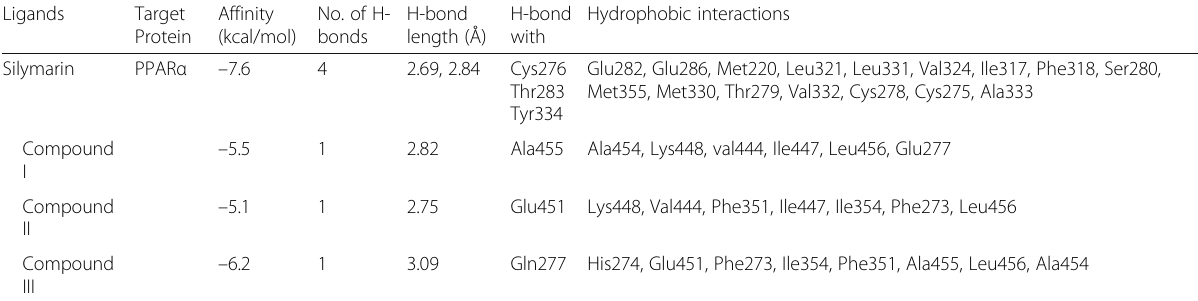
Table 6 Binding energy, No. of H- Bonds, H- Bond length, H-bond with and hydrophobic interactions of PPAR α ligands with receptors Ligands Target Affinity No. of H- H-bond H-bond Protein (kcal/mol) bonds length (Å)